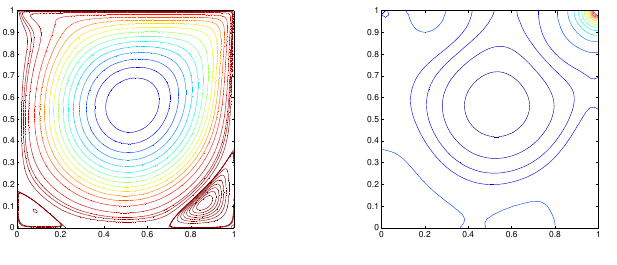
Figure 3. Computed streamlines(left) and pressure contours(right) for lid-driven cavity flow at Re=1000.